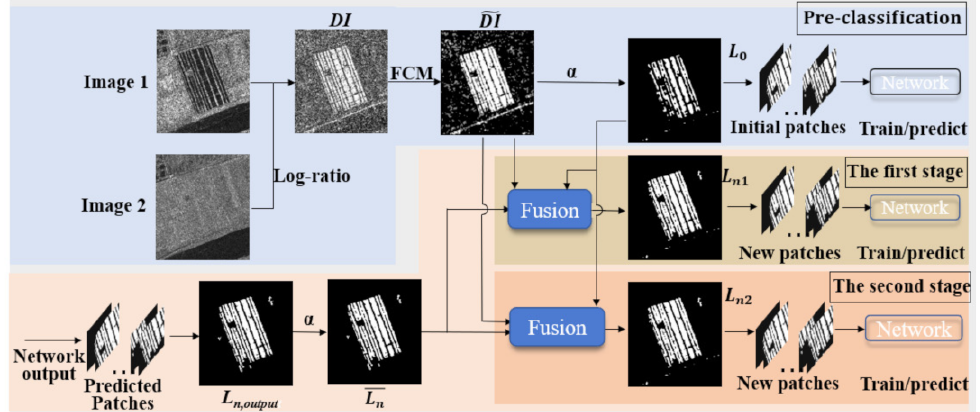
Figure 4. Illustration of label generation operations for each stage. At the pre-classification stage, the initial label L 0 is generated from synthetic aperture radar (SAR) images and contains the least data diversity. Patches are predictions of the designed network. All patches will be spliced into a map, and the map will be processed to be a new label for the next learning iteration. L n 1 is the label generated from the stage one updating process, while L n 2 is the label generated from the stage two updating